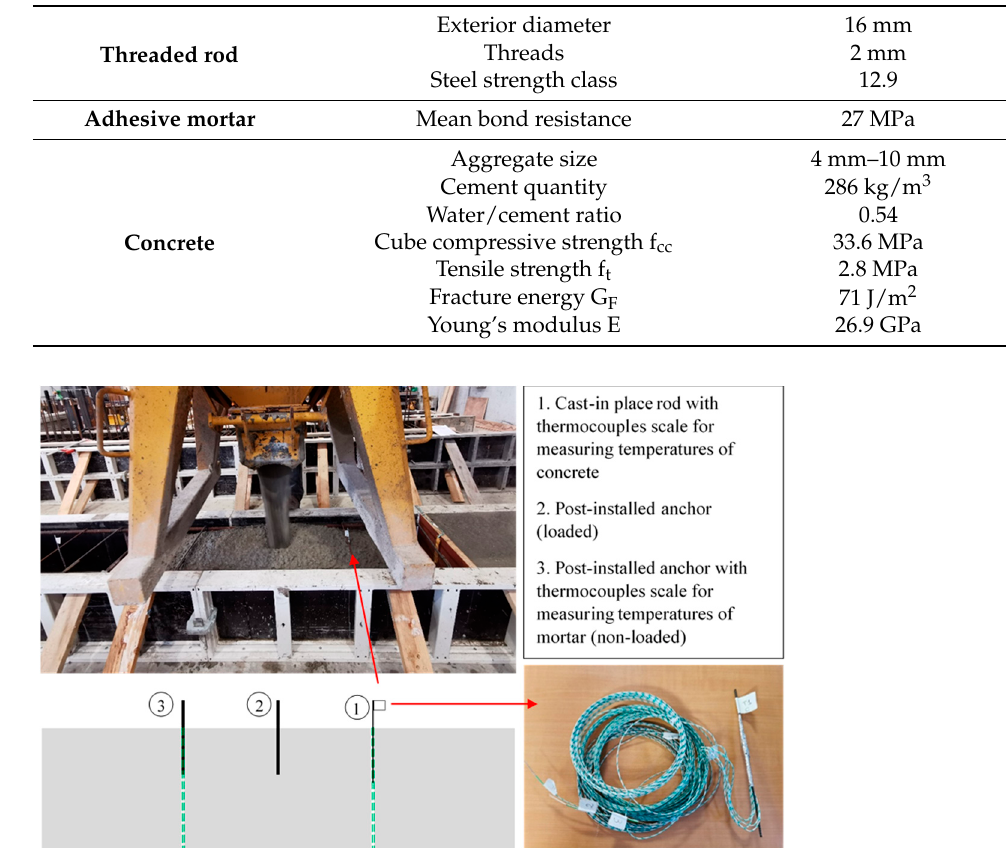
Table 2. Characteristics of the materials.